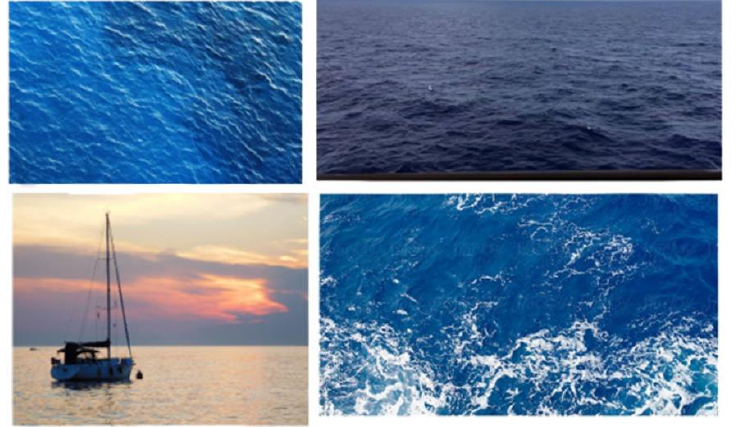
Figure 6. Background images.